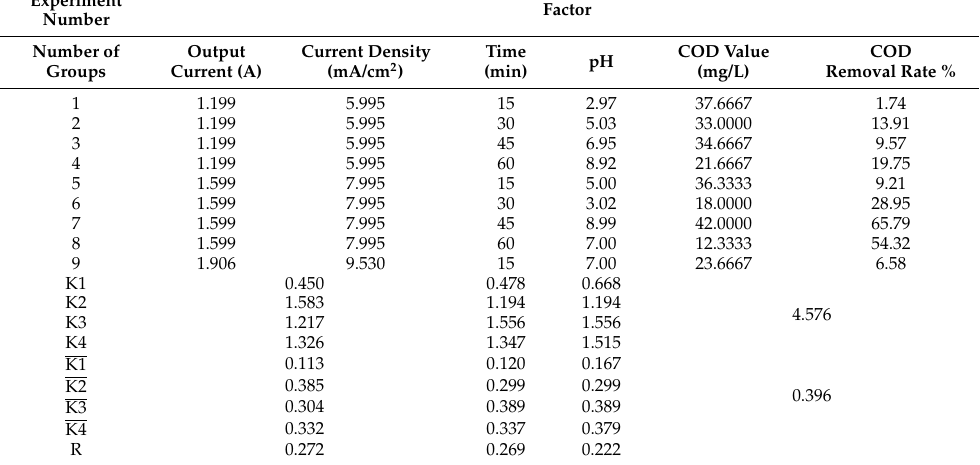
Table 3. COD removal rate.